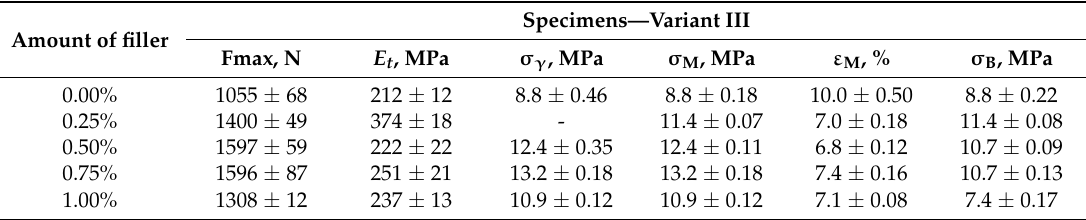
Table 5. Mechanical properties of the modified adhesive specimens prepared with Method I after the seasoning—Variant III (mean